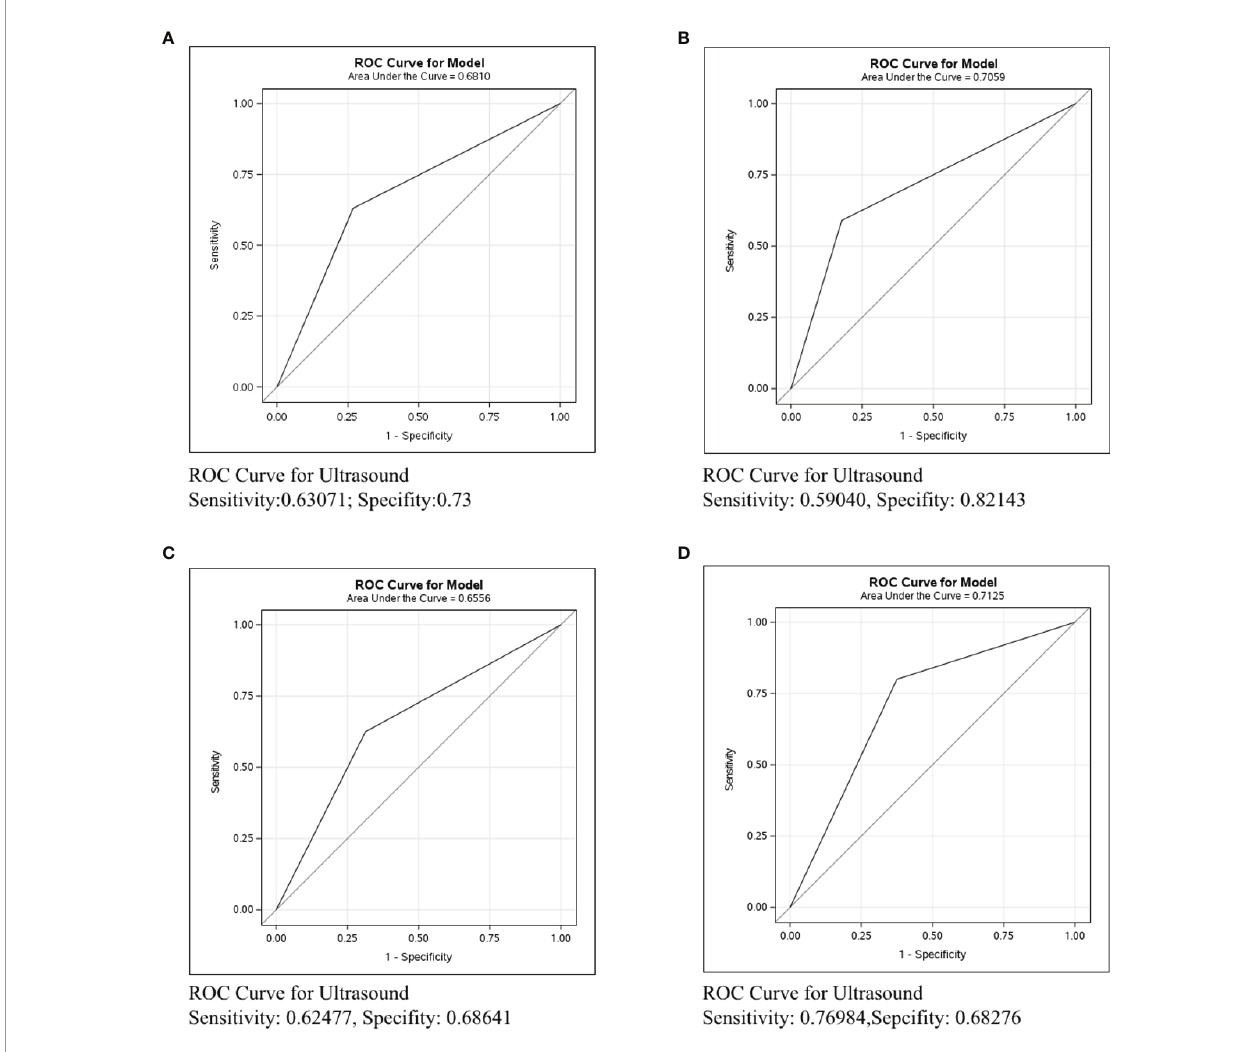
FIGURE 6 | ROC curve analysis for Ultrasound in all molecular subtypes. The vertical axis is sensitivity, the horizontal axis is 1-speci fi city. AUC is a parameter used to measure the value of ultrasound in the prediction of axillary lymph nodes. (A) ROC curve in all molecular subtypes. (B) ROC curve in ER/PR+Her2- subtype. (C) ROC curve in Her2+ subtype. (D) ROC curve in ER/PR-Her2-